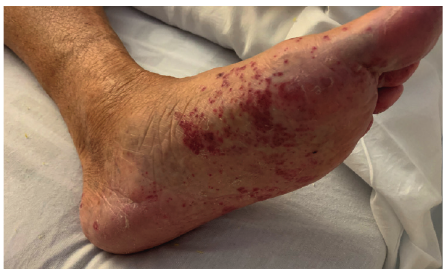
Figure 1: Rash of the left lower extremity.